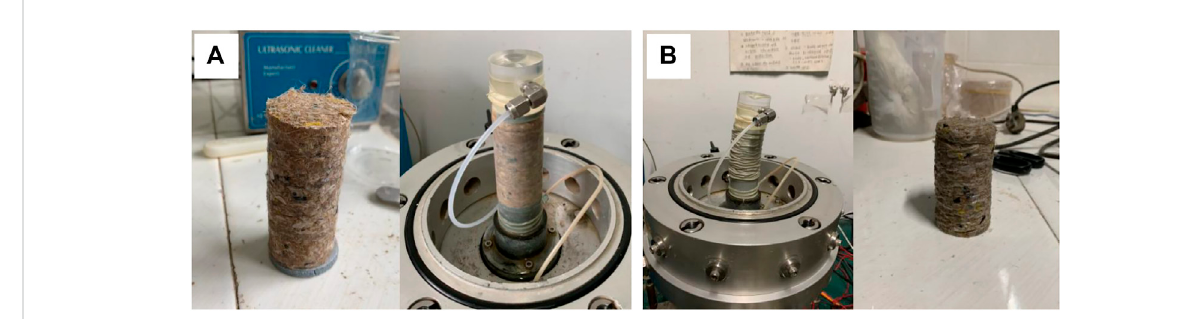
MSW specimens before (A) and after (B) triaxial